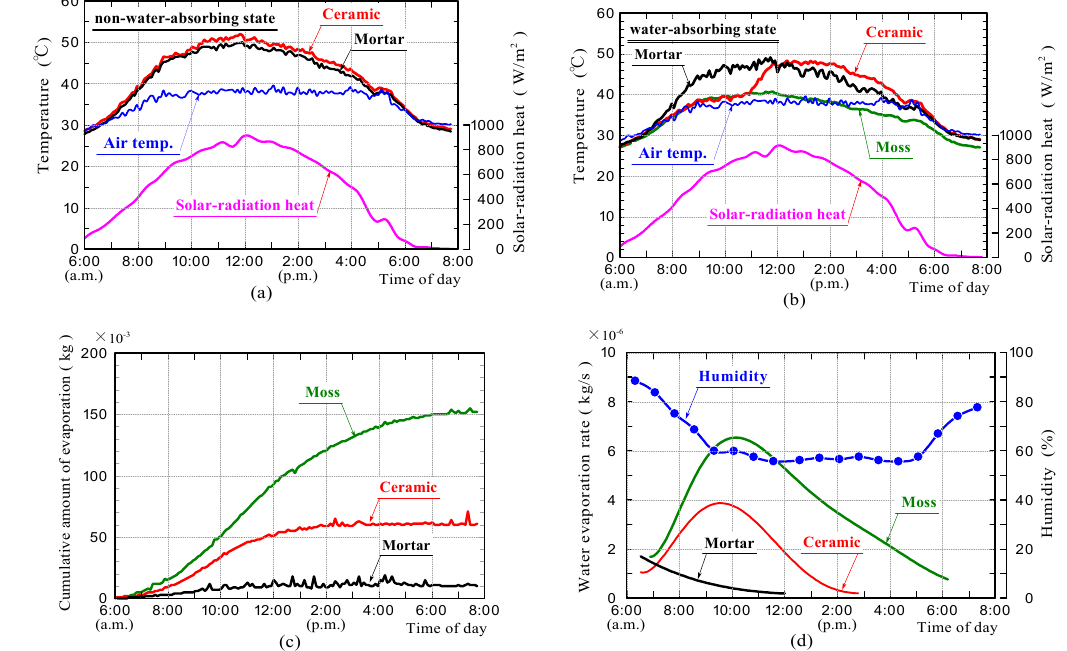
Figure 14. Surface-temperature changes of samples in the non-water absorbing and water absorbing states ( a , b ), amount of water evaporated from samples ( c ), and water evaporation rate and humidity ( d ) in field experiments.